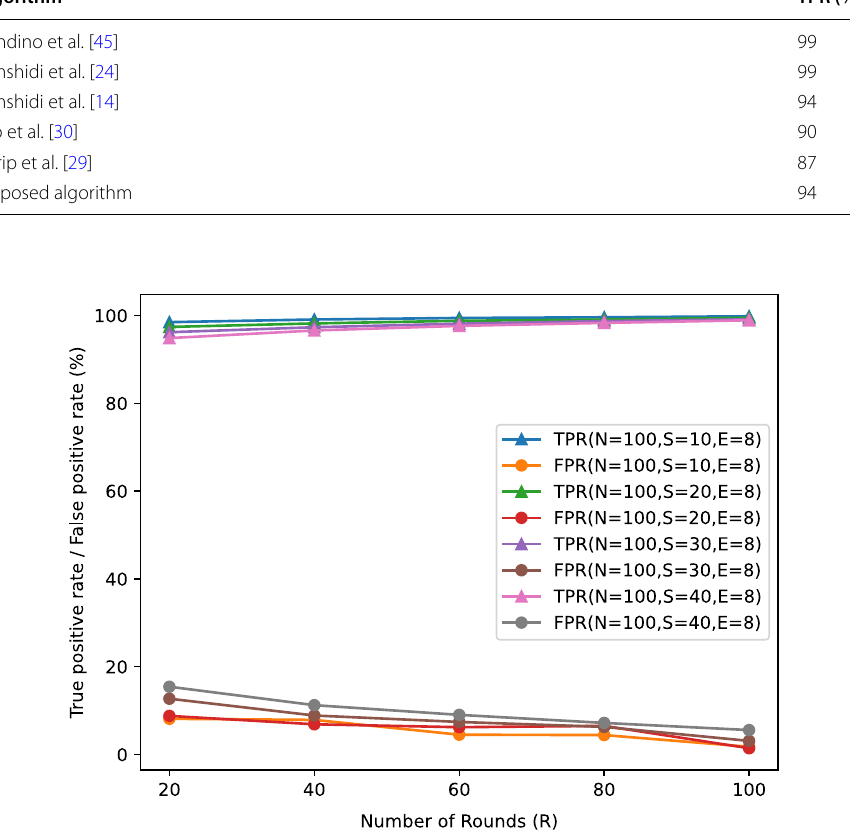
Fig. 5 Effects of the number of Sybil nodes S on detection